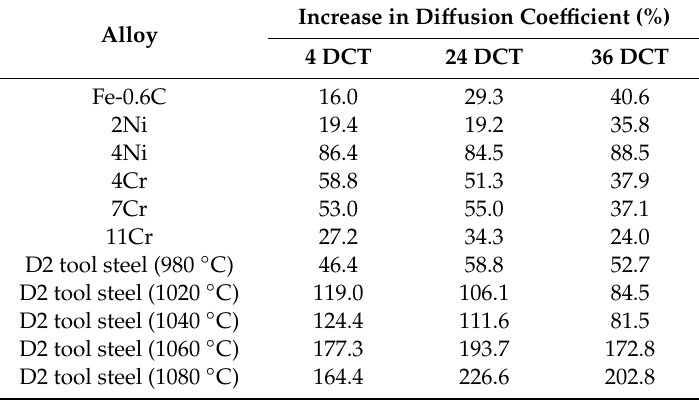
Table 3. Percentage Increase in E ff ective Di ff usion Coe ffi cient as Compared to the “As Quenched” Condition. 4 Deep Cryogenic Treatment (DCT) = 4 h of Deep Cryogenic Treatment, 24 DCT = 24 h of Deep Cryogenic Treatment, 36 DCT = 36 h of Deep Cryogenic